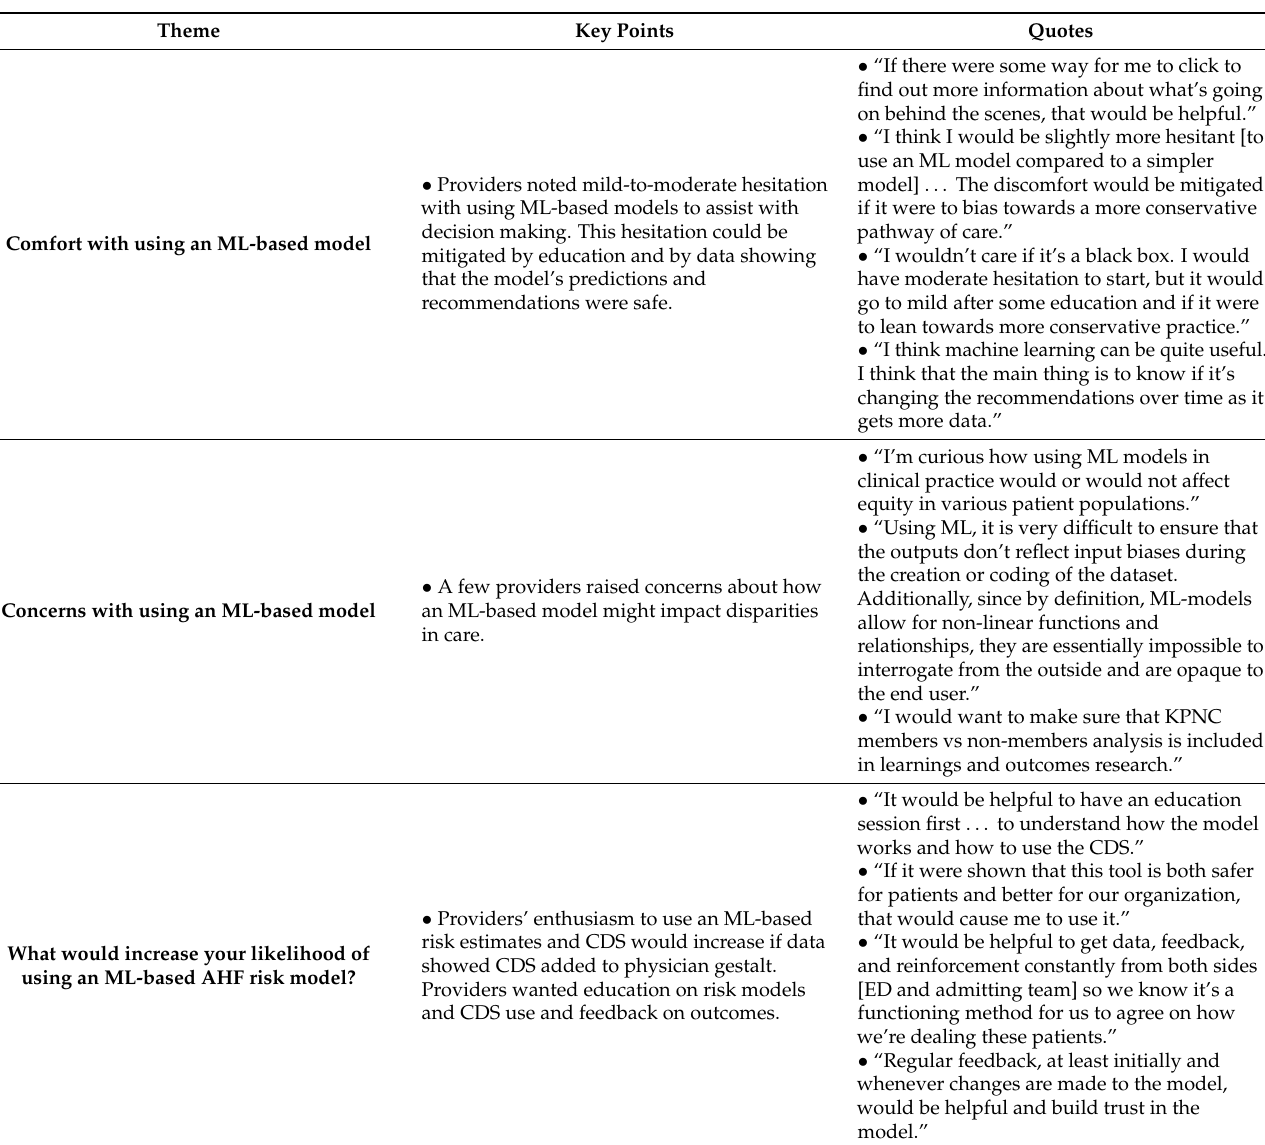
Table 3. Themes and representative quotes from qualitative interviews with physicians related to opportunities to increase comfort using an ML-based AHF risk